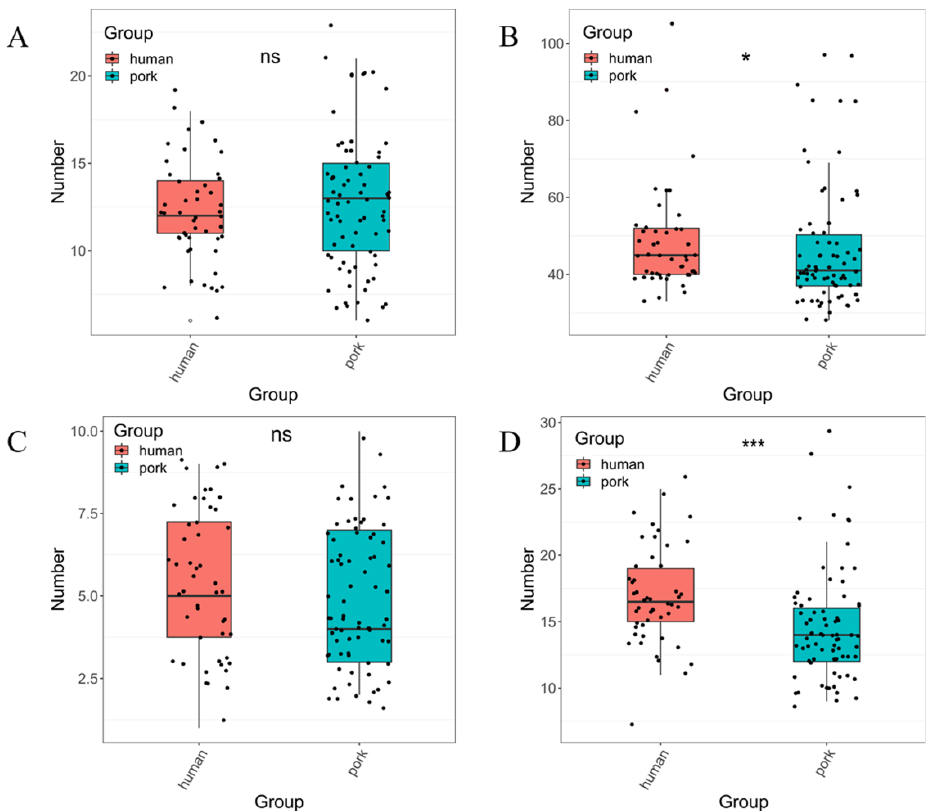
Figure 2. Genome analysis of 122 tet (X4)-positive E. coli collected from this study and NCBI database. ( A ) Number of ARGs carried by E. coli from different sources. ( B ) Number of virulence genes carried by E. coli from different sources. ( C ) Number of plasmid replicon types carried by E. coli from different sources. ( D ) Number of insertion sequences carried by E. coli from different sources. A dot represents an isolate. *: p < 0.05; ***: p < 0.001; ns: p > 0.05.